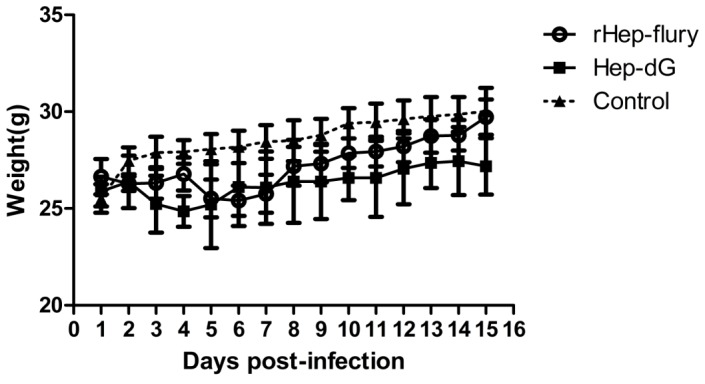
Body weigh changes in adult mice inoculated with the HEP-dG or rHEP-Flury.Ten mice per group were inoculated intracerebrally with HEP-dG (▪) or rHEP-Flury strain (○) at 5×104 FFU per mouse or were mock-inoculated (▴). The changes are shown as ratios to body weights of mice at day 0 and taken as 1.